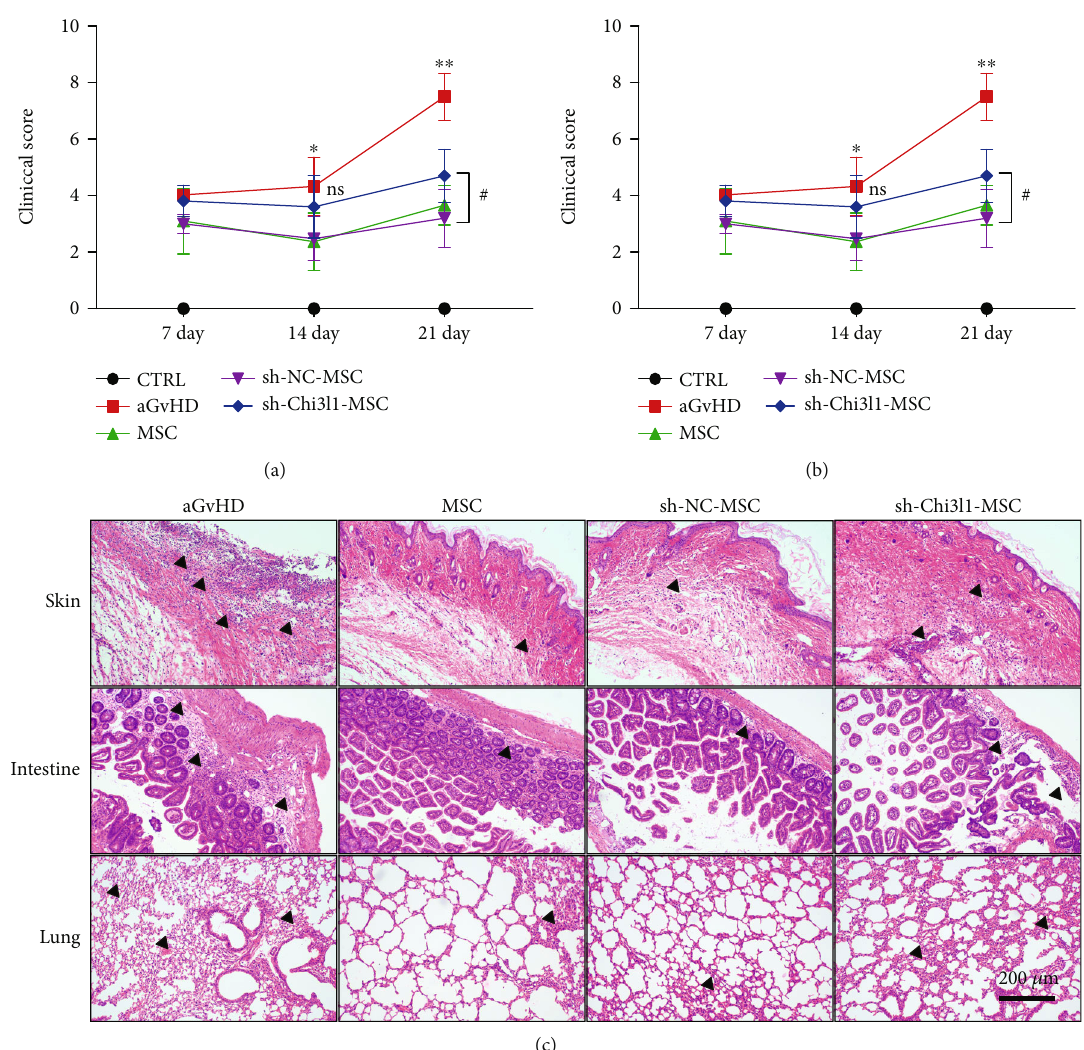
Figure 3: Chi3l1 deletion impairs the therapeutic e ff ects of hUC-MSCs in aGvHD mice. (a – c) Recipient mice (BALB/C) were irradiated with a single dose of 800 cGy total body irradiation (Co 60 γ source) and intravenously injected with C57BL/6J bone marrow cells ( 1 × 10 7 ) plus splenocytes ( 1 × 10 7 ) to induce the aGvHD model. Two days after transplantation, di ff erent MSCs, including hUC-MSCs, sh- Chi3l1-MSCs, sh-NC-MSCs ( 1 × 10 6 ), or PBS, were injected intravenously into aGvHD mice. (a) Survival curves of each group of